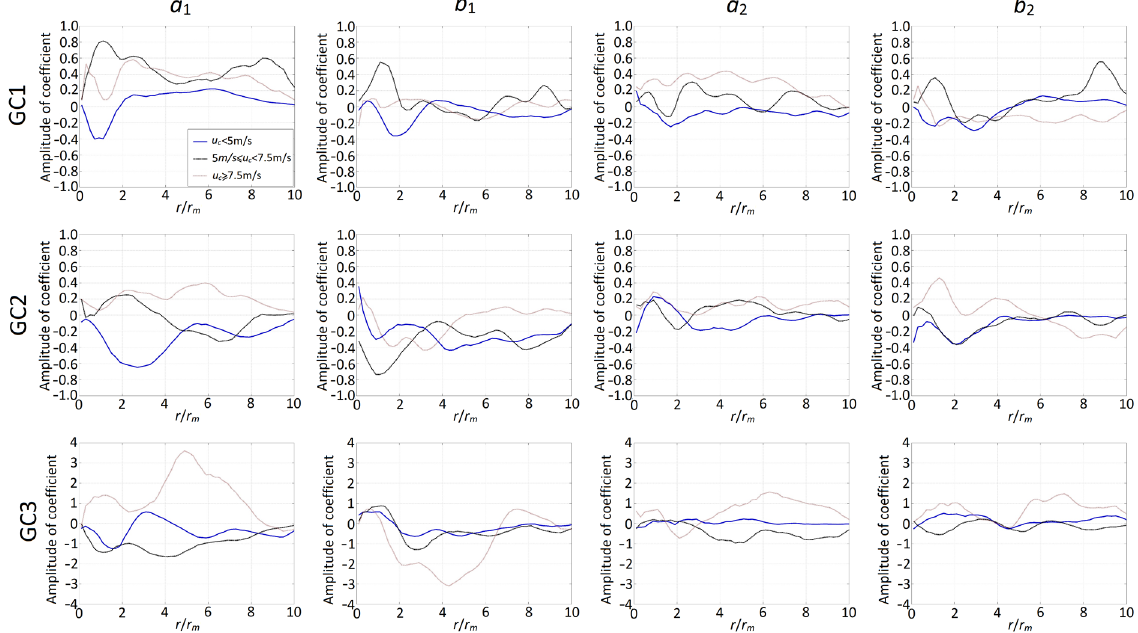
Figure 5. Coefficients for the asymmetric rainfall intensity field for Case 2. The first to third rows correspond to GC1 to GC3, respectively. a k ( r / r m ) and b k ( r / r m ) has units of mm/h, where k = 1 and 2.